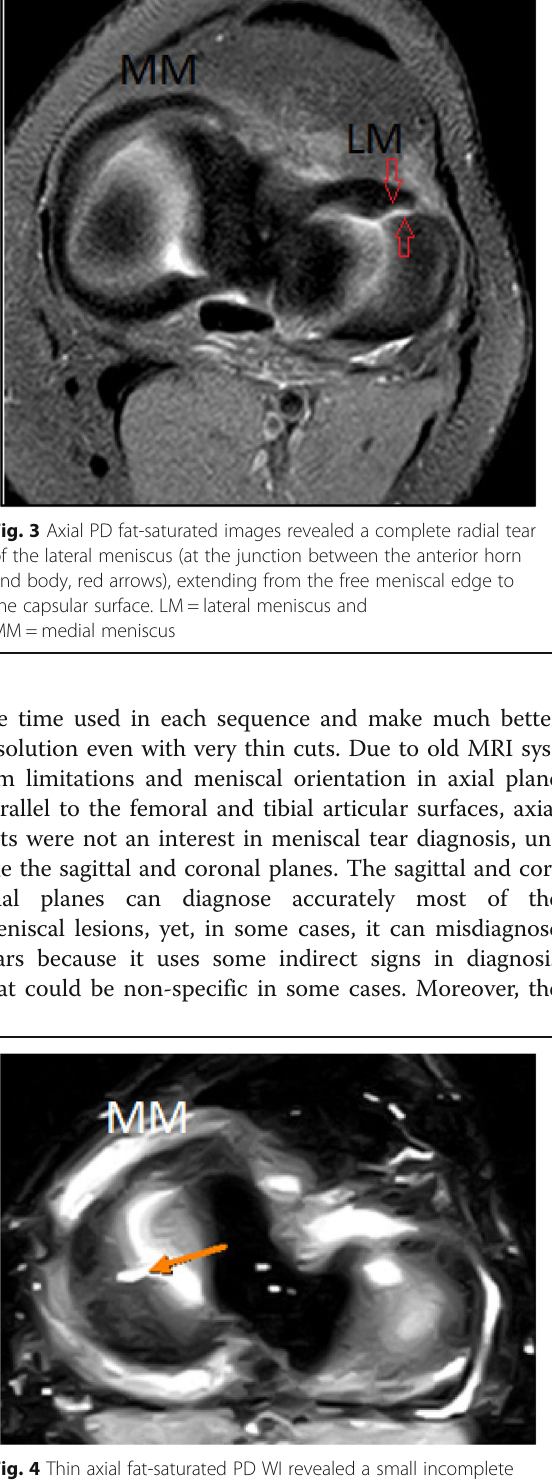
Fig. 2 Thin axial fat-saturated PD WI revealed a posterior horn medial meniscus root attachment tear (yellow arrow). MM = medial meniscus and LM = lateral meniscus